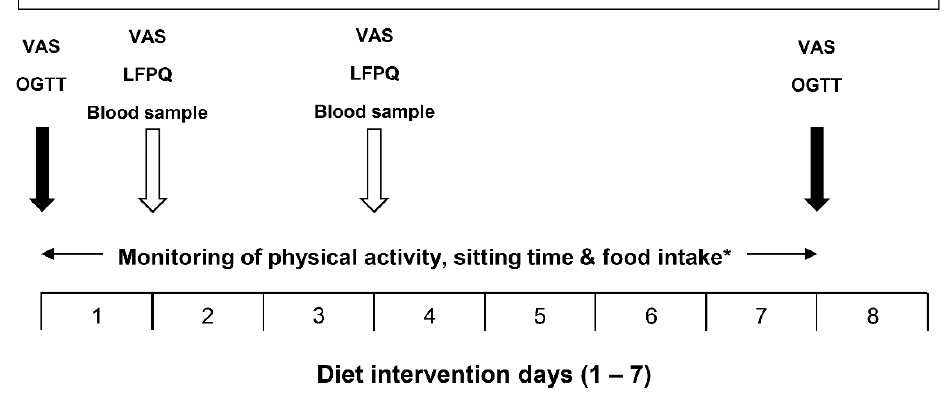
Figure 1. Schematic illustration of the main trial protocol. HE-HFD, hyperenergetic high-fat diet; VAS, visual analogue scale; OGTT, oral glucose tolerance test; LFPQ, Leeds Food Preference Questionnaire. * Physical activity, sitting time and food intake data collected during the control diet and the HE-HFD have been reported previously [30].